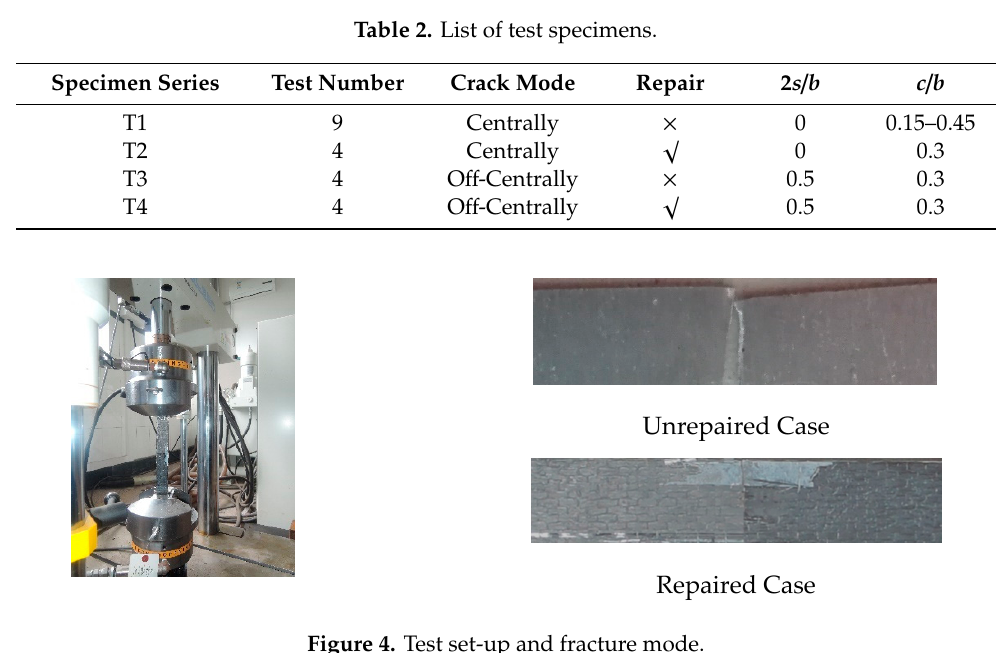
Figure 4. Test set-up and fracture mode. Table 1. Mechanical properties of test materials.